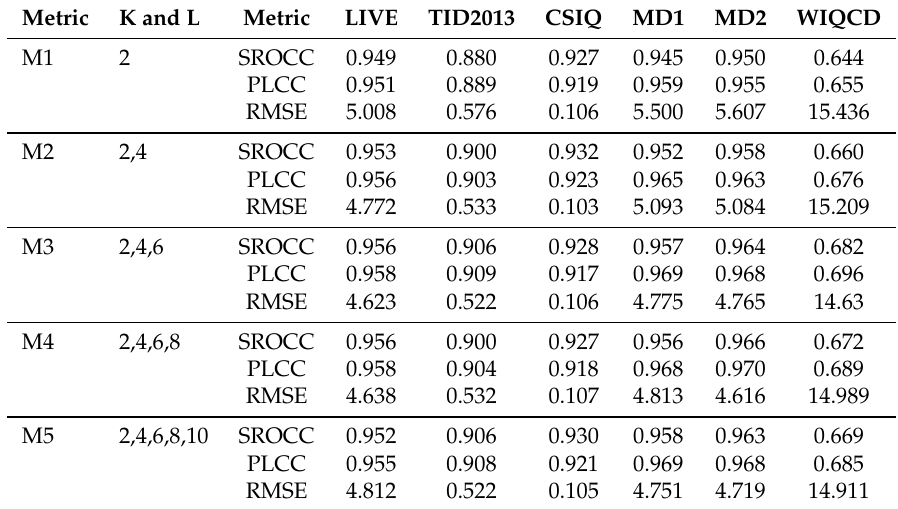
Table 5. Median SROCC of BIQA-SC on six databases when using different numbers of NFMs, where